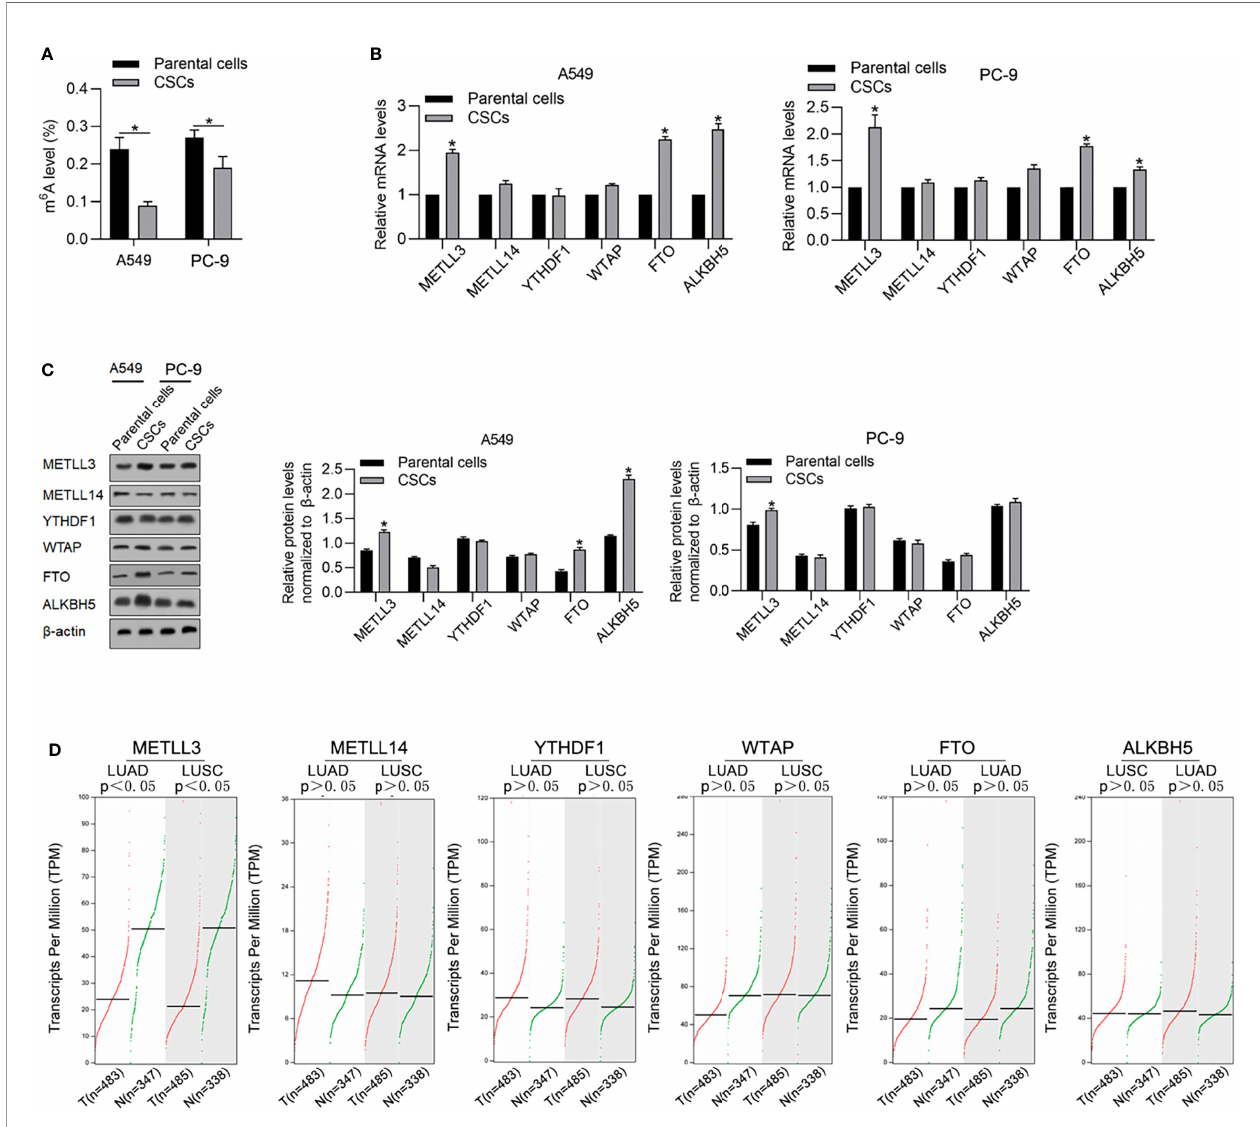
FIGURE 2 | CSCs present a relatively lower m 6 A methylation level compared with their parental cells. (A) Global m 6 A methylation was measured in CSCs and its parental cells of A549 and PC-9. * p < 0.05 vs. parental cells. m 6 A methylation-relative gene expressions including METLL3, METLL14, YTHDF1, WTAP, FTO, and ALKBH5 were measured in mRNA (B) and protein levels (C) . (D) By employing the GEPIA database analysis tool, the relative mRNA levels of METLL3, METLL14, YTHDF1, WTAP, FTO, and ALKBH5 were compared between tumor samples and nontumor